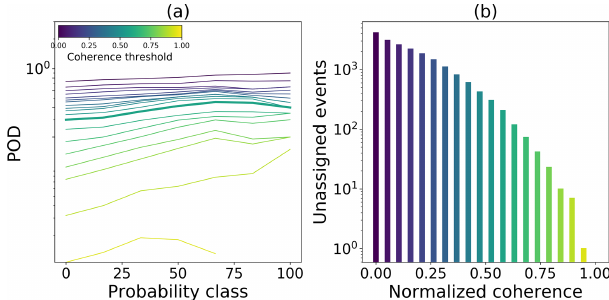
Figure 11. (a) POD for each probability class depending on the minimal coherence (colors). (b) Number of unassigned events for different coherence threshold values (colors).